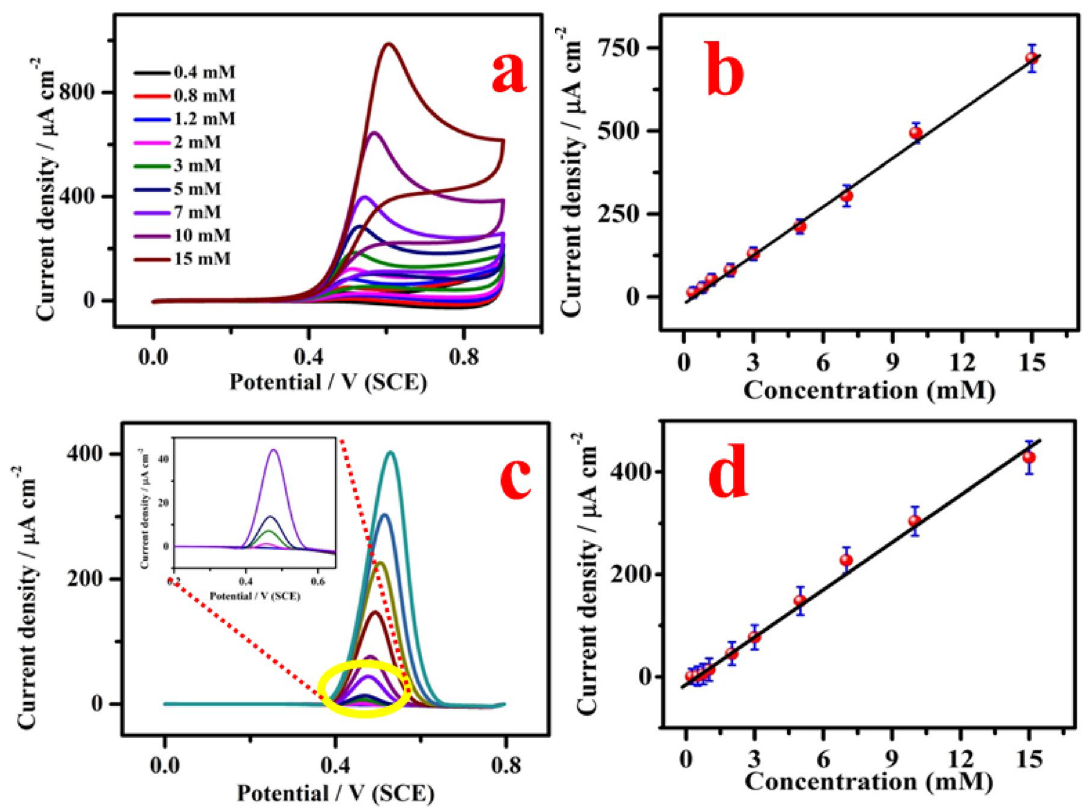
Figure 9. ( a ) CV of CuO/GCE in 0.1 M PBS (pH 7.0) containing 0.4, 0.8, 1.2, 2.0, 3.0, 5.0, 7.0, 10.0 and 15.0 mM of SO 3 2− ; ( b ) corresponding calibration curve (n = 3). ( c ) Differential pulse voltammogram of CuO modified electrode in 0.1 M PBS pH 7 concentration ranges from 0.2, 0.3, 0.5, 0.75, 1.0, 2.0, 3.0, 5.0, 7.0, 10.0 and 15.0 mM of SO 3 2− . Insert shows the low concentration region and ( d ) a plot of current density with respect to the concentration (n = 3). (DPV parameters: step potential = 0.0050 V; modulation amplitude = 0.0250 V; modulation time = 0.20 s and interval time-0.5 s).